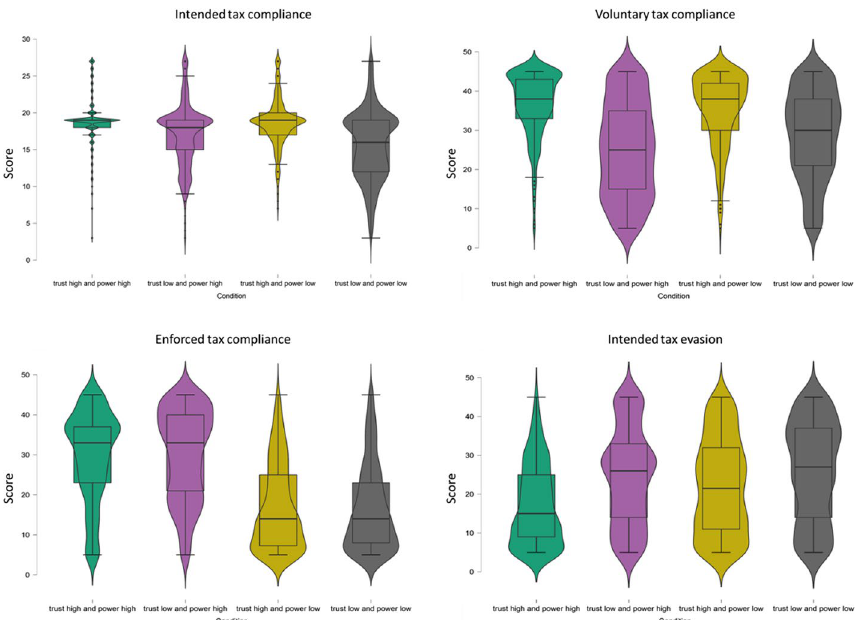
Fig. 1 Box plots and violin plots of tax compliance measures by condition